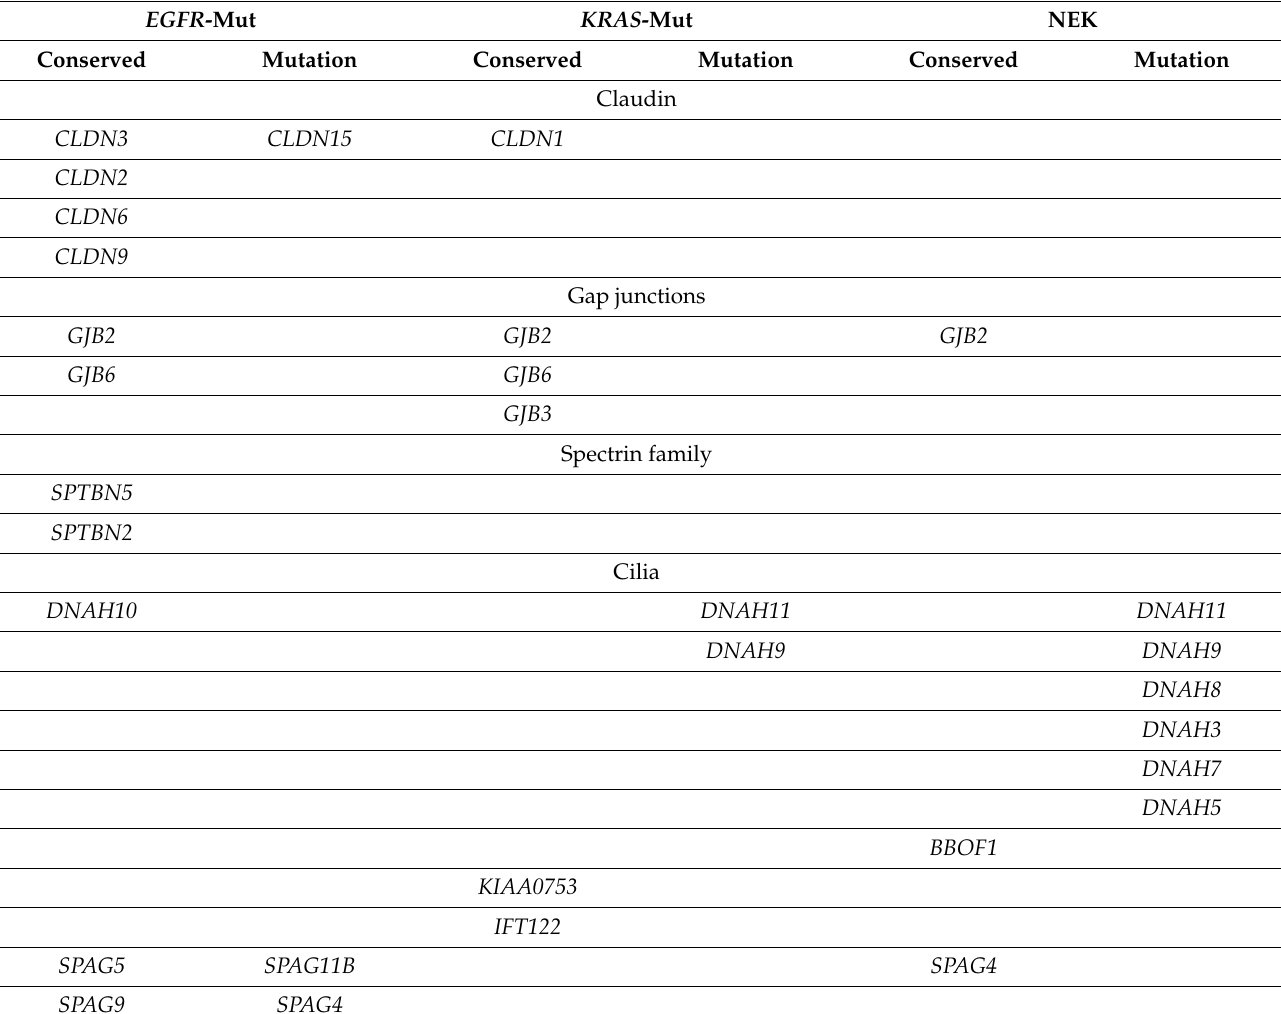
Table 4. Evolutionary selection in genes associated with cell